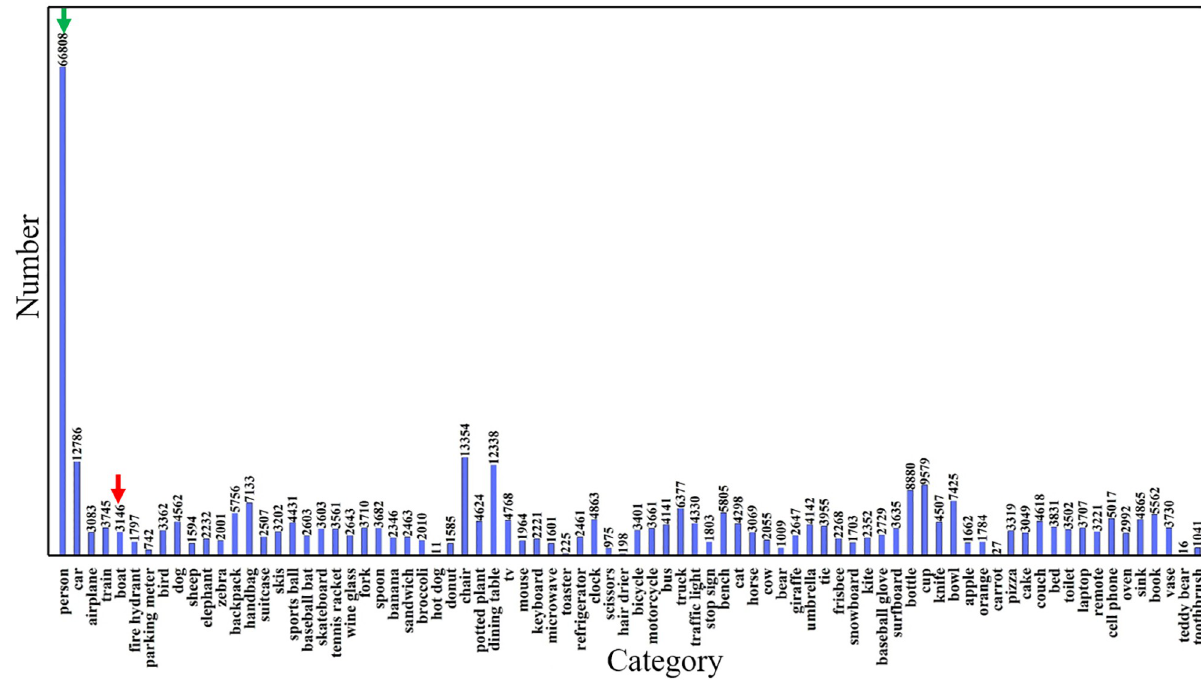
Fig 1. Distribution of the numbers of individual categories in the MS COCO dataset. The dataset has a total number of 80 categories, where the green and red arrows represent the number of images in the ‘person’ and ship category respectively.